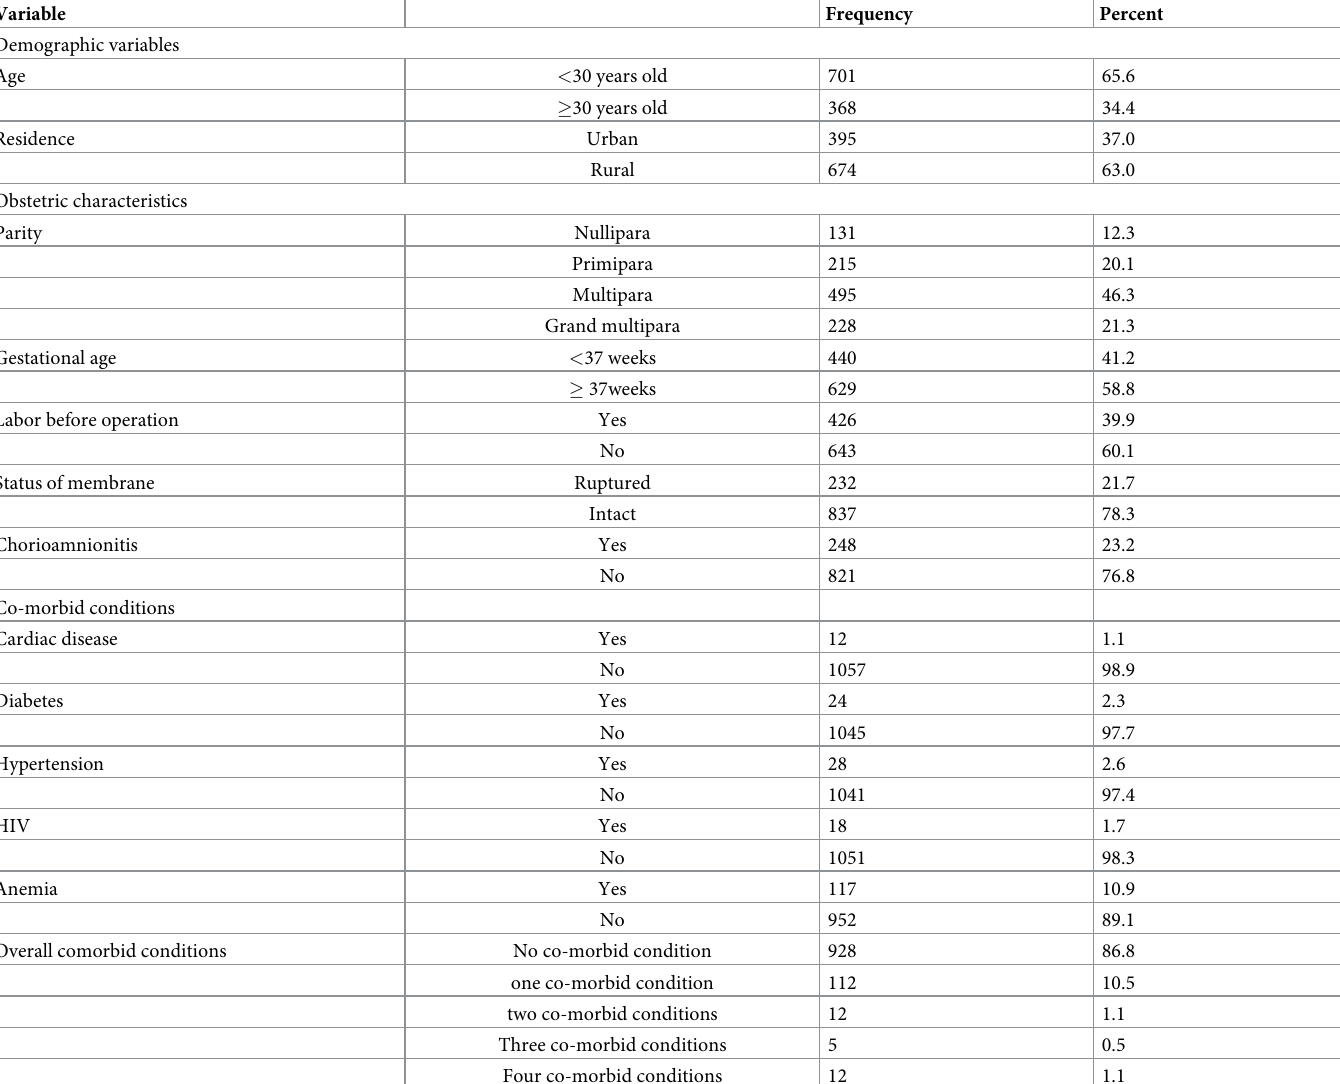
Table 1. The demographic and obstetric characteristics of women for whom cesarean section was conducted in two public hospitals in Harar city, East Ethiopia. Variable Demographic